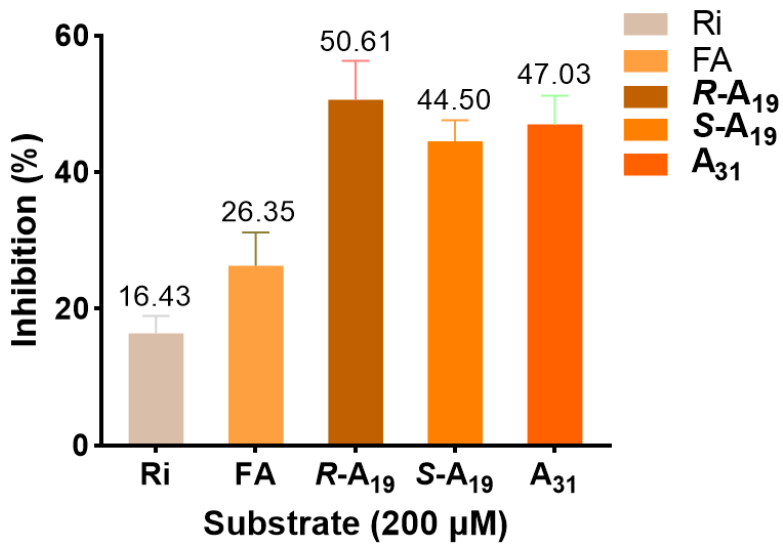
Figure 9. The inhibitory activity of target compounds and Ri against the TMV helicase at 200 μ M.